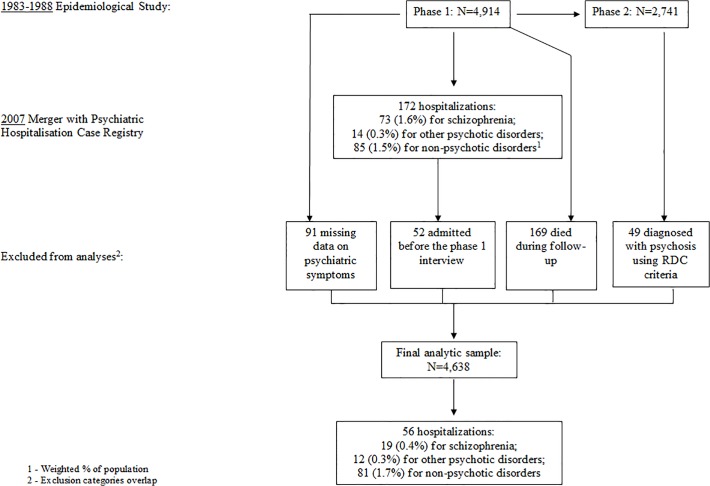
Study population.